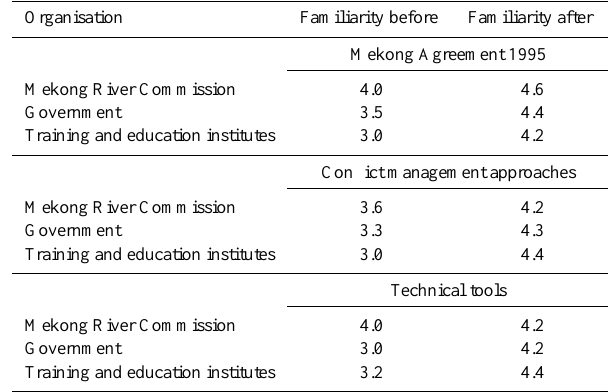
Table 5. Familiarity with the three knowledge areas taught in rela- tion to addressing transboundary issues before and after the MRC- FMMP Capacity Building Programme, per organisation (n = 37) ∗ .